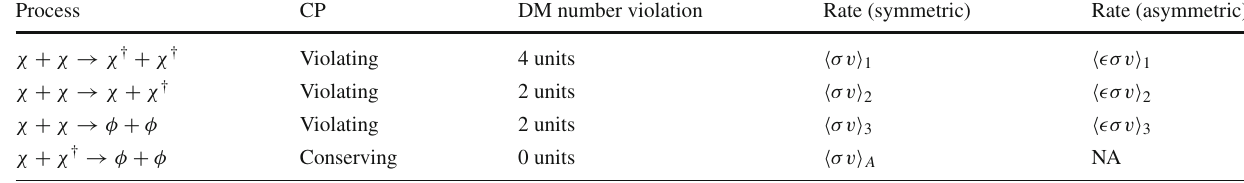
Table1 RelevantprocessesforDMcosmologyfortheADMfromscatteringscenario,theirproperties,andnotationusedtodenotethecorresponding thermally averaged symmetric and asymmetric reaction rates